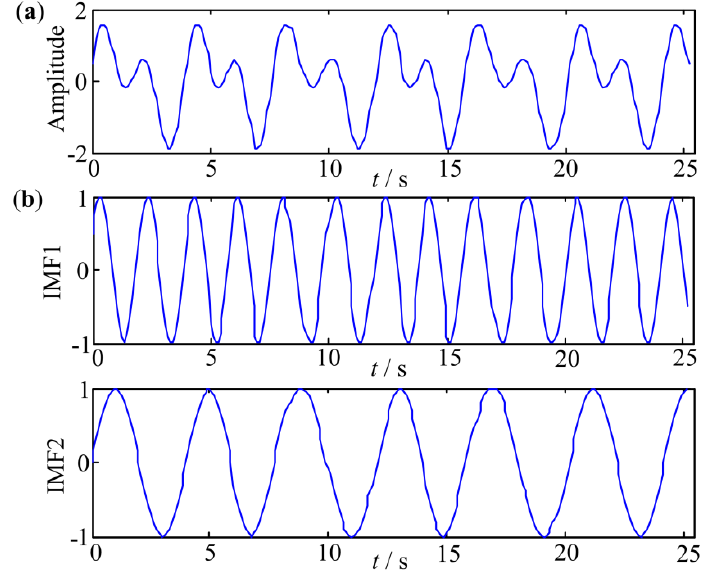
Figure 2. The signal p * ( t ) and its ideal empirical mode decomposition (EMD) decomposition results: ( a ) The original signal, ( b ) Two intrinsic mode functions (IMF) components.